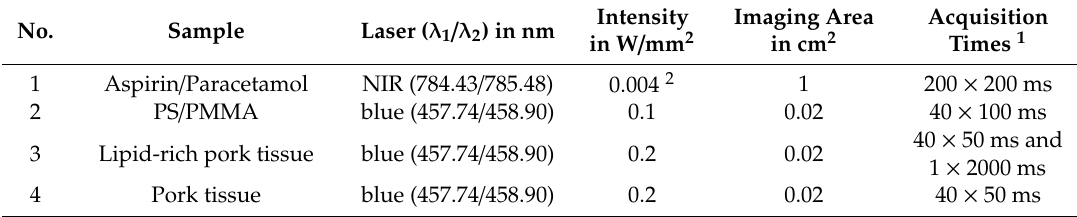
Table 1. Overview over the technical measurement conditions shown by